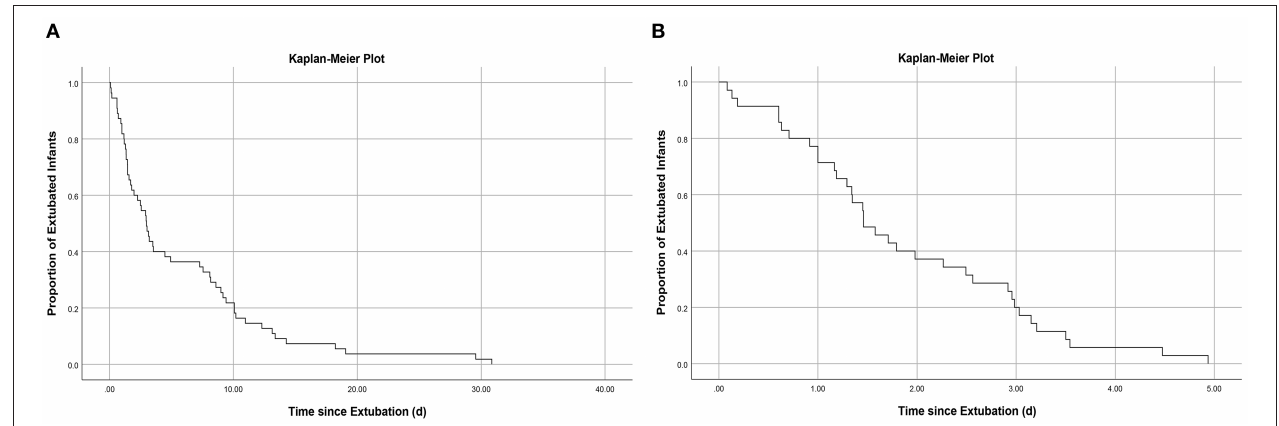
FIGURE 1 | (A) Kaplan–Meier curve showing proportion of infants remaining extubated during hospitalization: Among those who failed extubation during hospitalization, 63.6% underwent reintubation within 5 days; (B) Kaplan–Meier curve showing proportion of infants remaining extubated within 5 days: Among those who failed extubation within 5 days, 80.0% underwent reintubation within 3 days.